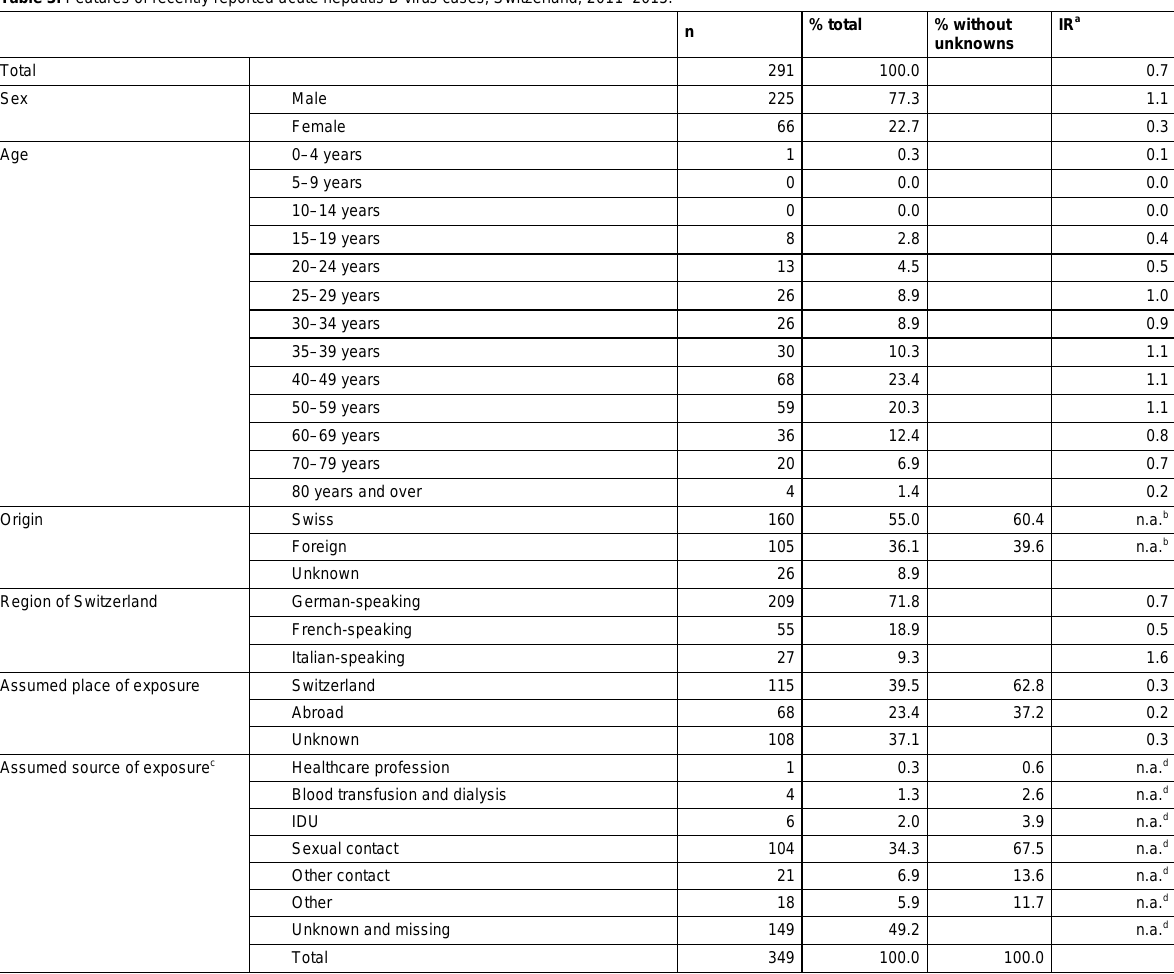
Table 3: Features of recently reported acute hepatitis B virus cases, Switzerland, 2011–2015.